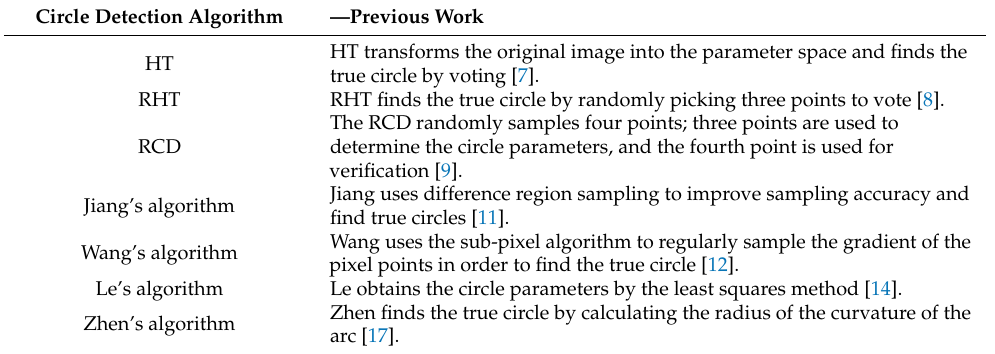
Table 1. Summary of previous work. Circle Detection